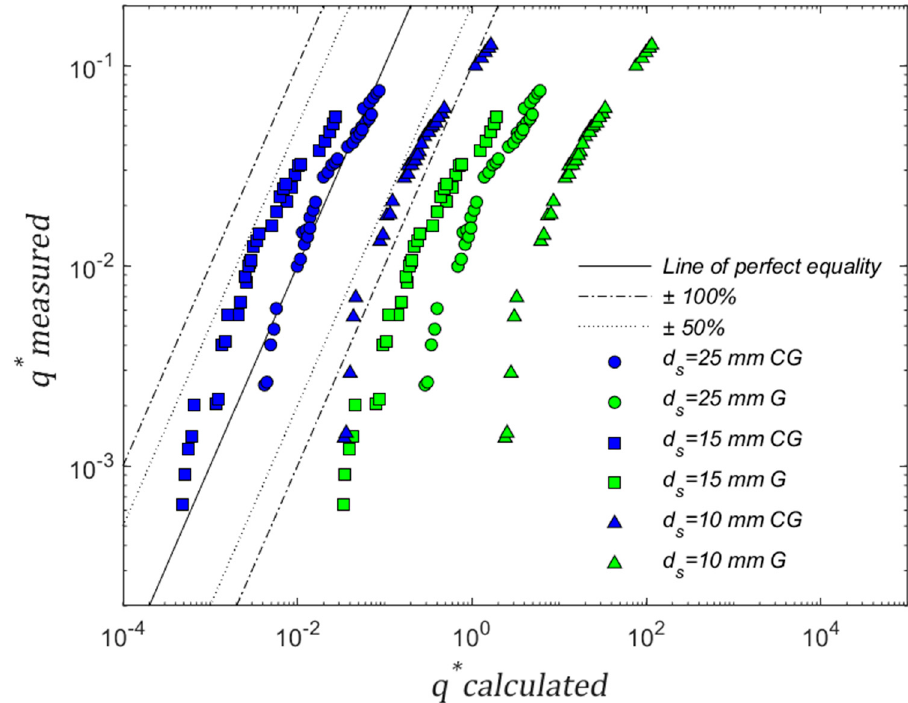
Figure 9. Comparison between predictions obtained using the corrected gravity (CG) and using gravity vector directly (G) for d s =10 mm (Case A), d s =15 mm (Case B), d s =25 mm (Case C).